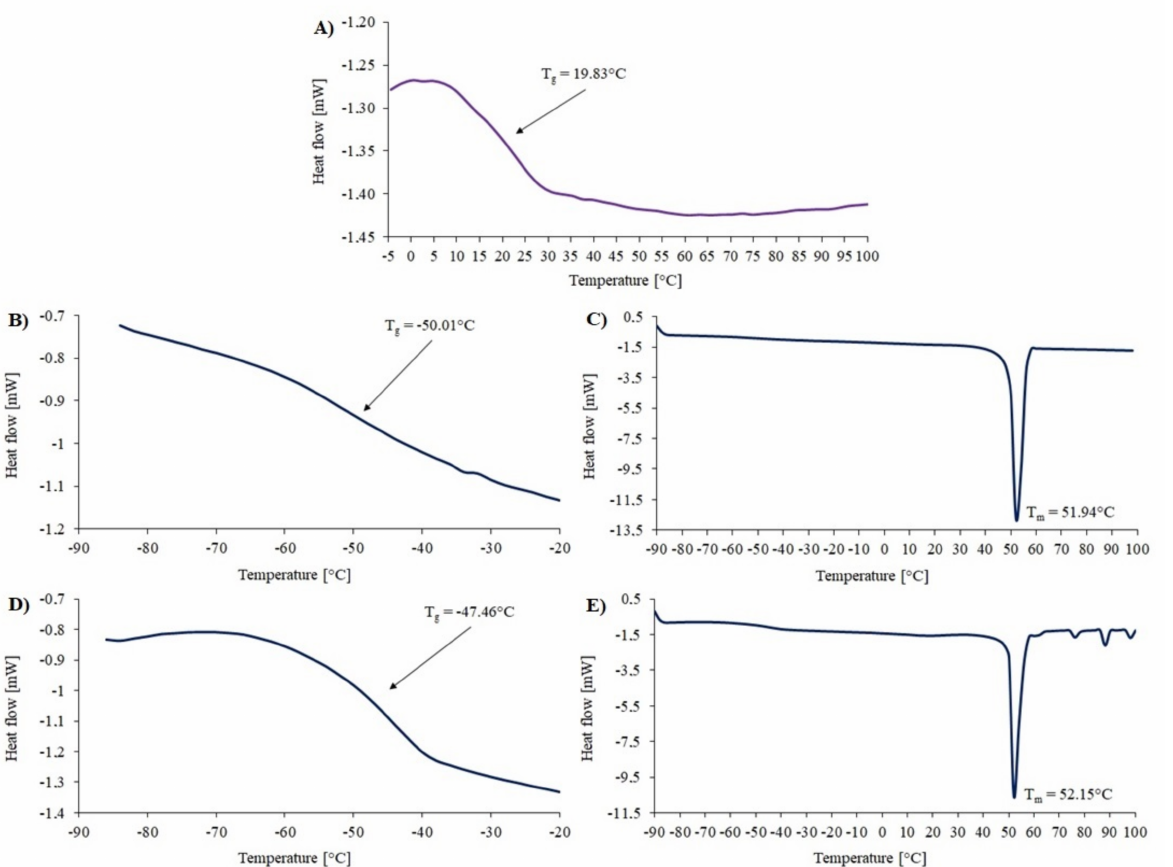
Figure 5. DSC thermogram for MI 1 ( A ) and MP1 before ( B , C ) and after ( D , E ) degradation. Before degradation, a miktopolymer containing a PLGA copolymer in its structure had a lower T g (2.43 ◦ C) than a polymer with PLA (10.89 ◦ C) (Figure 6). The lower glass transition temperature may be due to the presence of GA units in the sequence structure [27]. According to the literature, the T g of PGA is 35–45 ◦ C. The theoretical T g for the PLGA copolymer is 50 ◦ C, while the resulting T g obtained by DSC is 2.43 ◦ C. This may indicate that a branched miktopolymer was obtained. Therefore, after degradation, the T g value for MP2 and MP3 increased. The T g depends on chain flexibility, molecular weight, and cross-linking. In that case, it seems that the T g increases after degradation due to